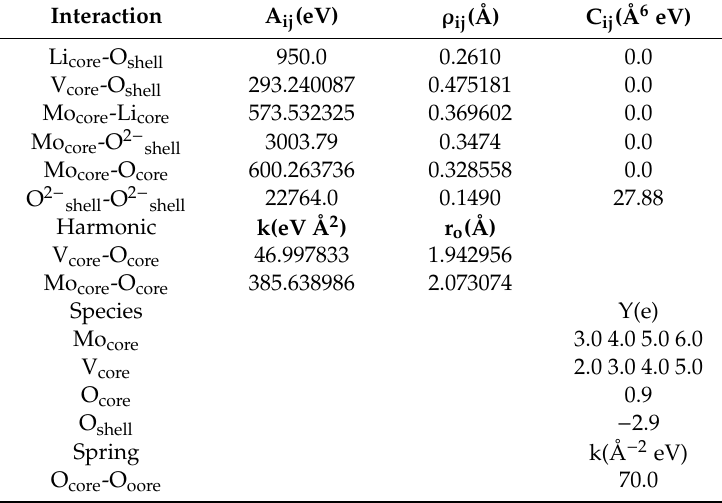
Table 1. Interionic potentials obtained from a fit to the VO, V 2 O 3 , VO 2 , V 2 O 5 , LiMoO 2 , Li 2 MoO 3 , Li 3 MoO 4 and Li 2 MoO 4 structures.